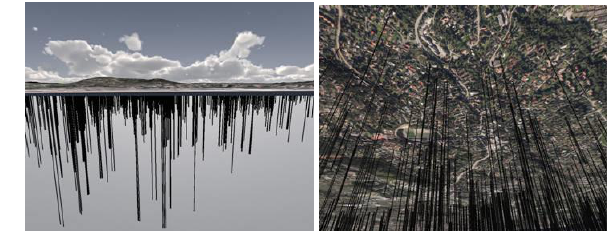
Figure 8: Left: The "Swiss cheese" of energy wells underneath Oslo city (A. Seither).Right: Energy wells underneath Oslo Figure 7: Model of triangulated polyhedron hulls in IGMAS+. Vertical sections and interfaces can be selected as convenient complicate the planning of new infrastructure, such as tunnels and colours are chosen to follow the international stratigraphy (A. Seither). chart.